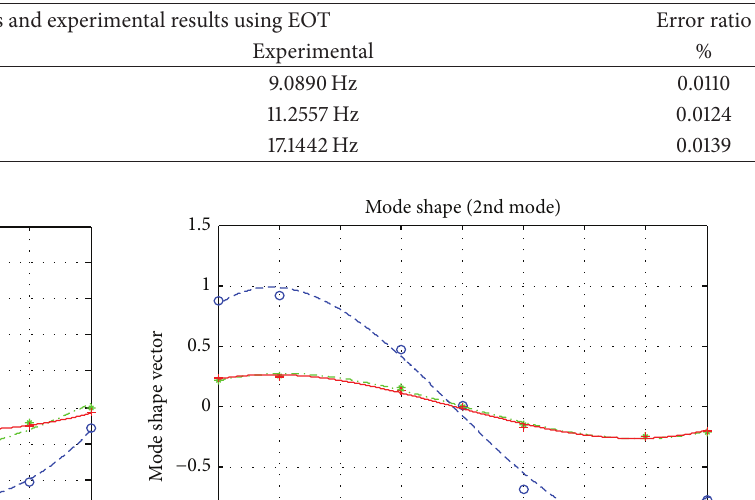
Table 10: Comparison of experimental results and updating results.